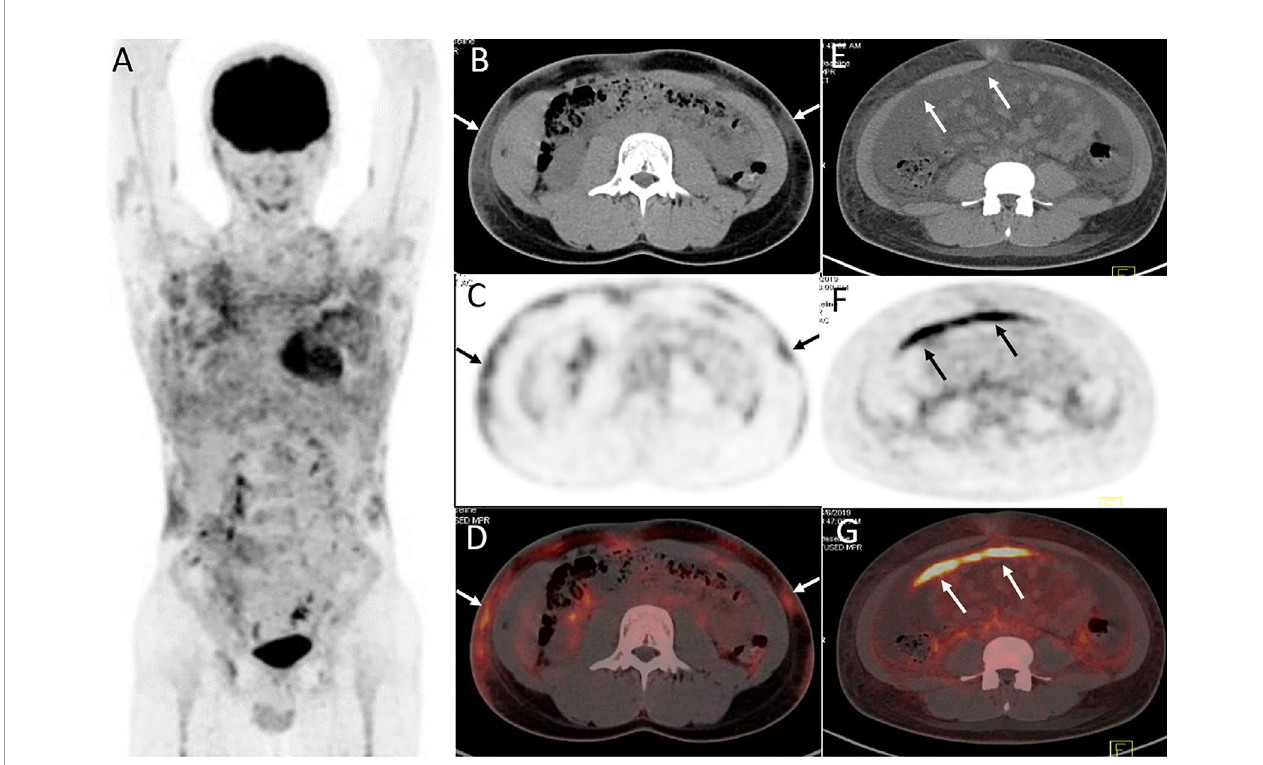
FIGURE 4 | Twenty-year-old male with subcutaneous panniculitis-like T-cell lymphoma. Three-dimensional maximum intensity projection image (A) , axial CT (B) , corresponding PET (C) and fusion PET/CT (D) images from 18 F-FDG PET/CT show hypermetabolic soft-tissue in fi ltrates subcutis diffusely in the trunk and both upper arms with ill-de fi ned borders (arrows), which are the typical patterns of the disease. Abdominal axial CT (E) , corresponding PET (F) , and fusion PET/CT (G) images from 18 F-FDG PET/CT clearly show a “ strip-like ” lesion with high uptake of 18 F-FDG in mesentery, which represents lymphoma involvement but it is negative on CT